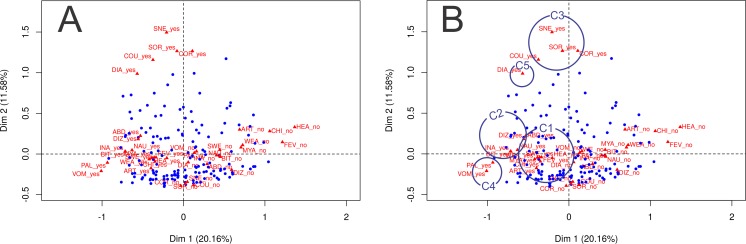
Joint distribution of the correspondence analysis dimensions for qualitative variables (parasitemia, number of previous malaria episodes and malaria species).(A) Joint distribution of the correspondence analysis dimensions for qualitative variables (parasitemia, number of previous malaria episodes and malaria species). Dimension 1 and 2 contribute to explain 31.74% of the variance. The contribution of each symptom in dimension 1 and 2 is represented as a triangle, where ‘yes’ indicates the contribution of the presence of the symptom, and ‘no’ indicates the contribution of the absence of the symptom. Subjects are represented as blue dots, and their position in each quadrant demonstrate the referred symptom profile of each individual (near the presence of symptoms or near the absence of symptoms). (B) Joint distribution of the correspondence analysis dimensions for qualitative variables (parasitemia, number of previous malaria episodes and malaria species) with circles indicating groups of symptoms identified in the cluster analysis. C1, Algic and fever-related symptoms; C2, Gastric symptoms; C3, Respiratory symptoms; C4, Vomiting and pallor; C5, Diarrhoea.